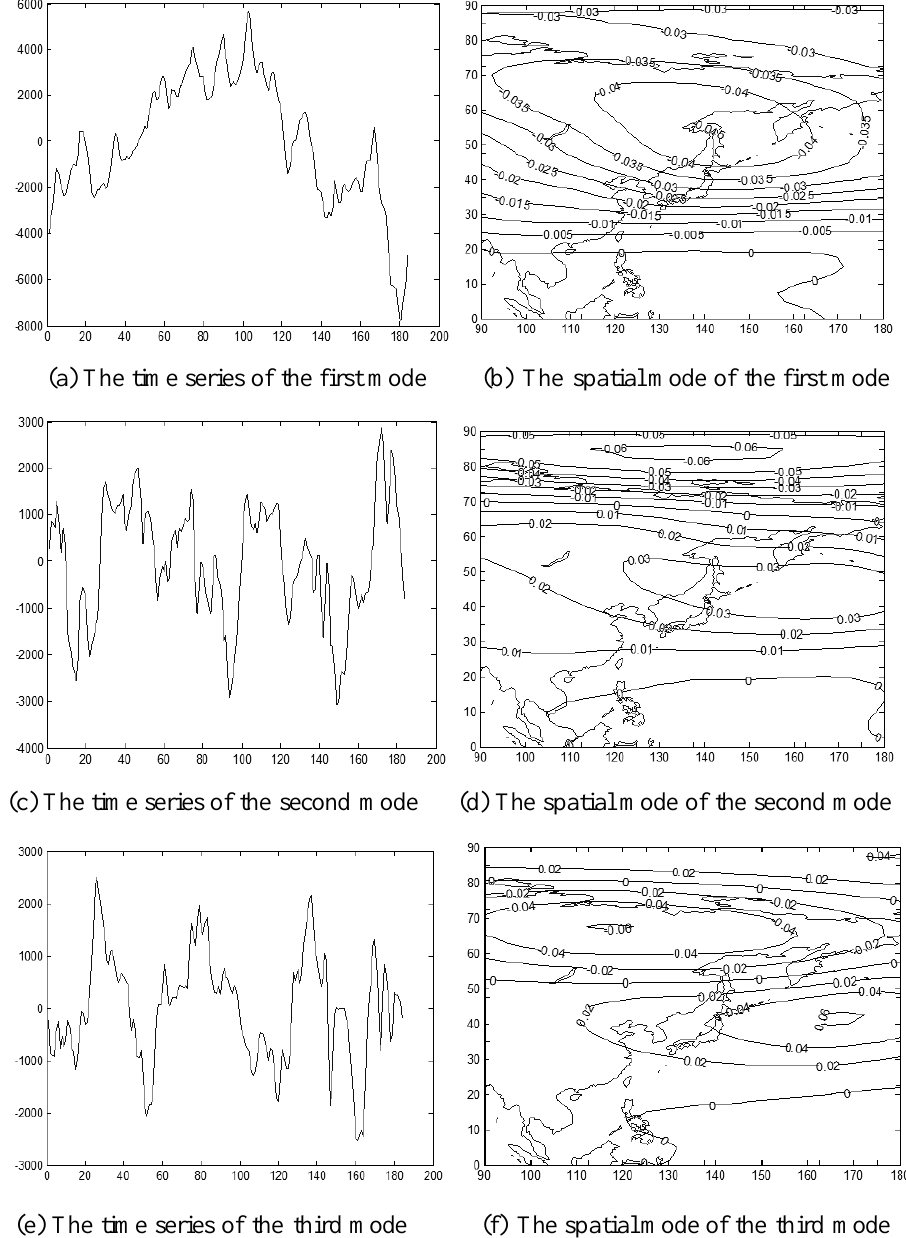
Fig .1 The time series and the spatial mode of the first three modes in 2003. Fig. 1. The time series and the spatial mode of the first three modes in